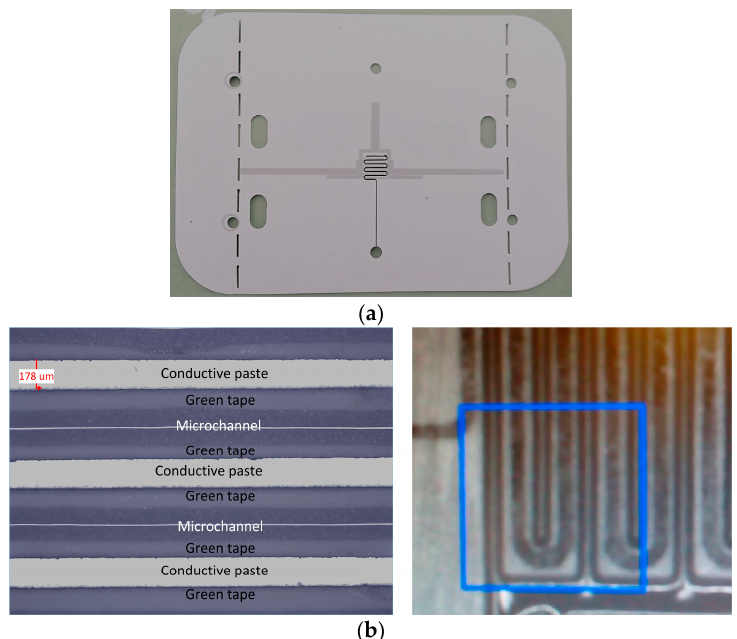
Figure 7. ( a ) Layer 3 after the cutting and screen printing processes; ( b ) Details of the interdigital capacitor with the meandered microfluidic channel in layer 3.